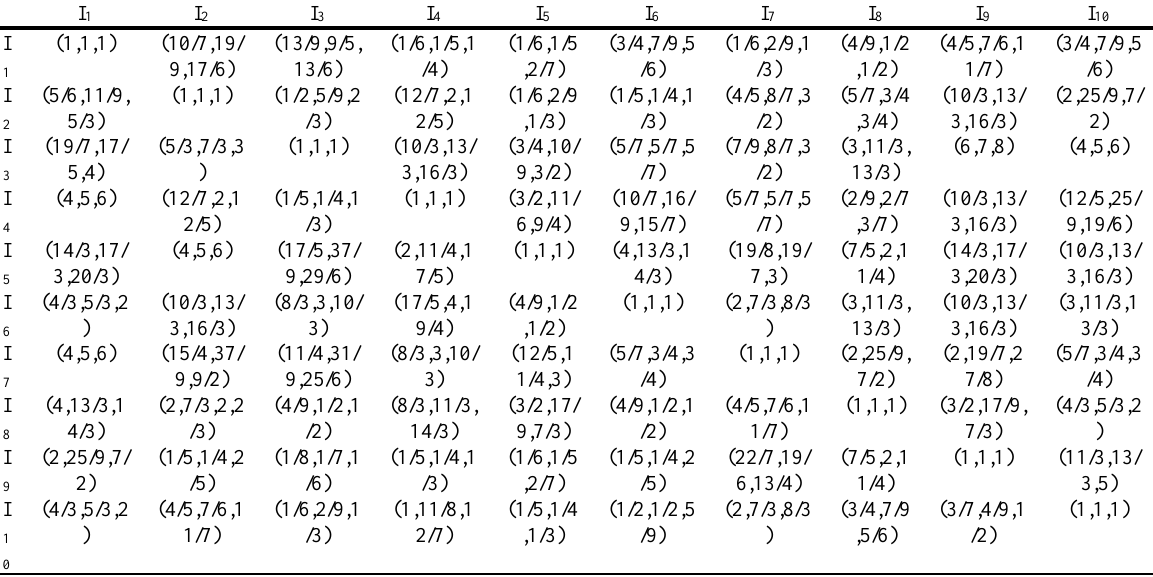
Table 11. Pair wise contribution matric for the factors of “Internal Chain”.